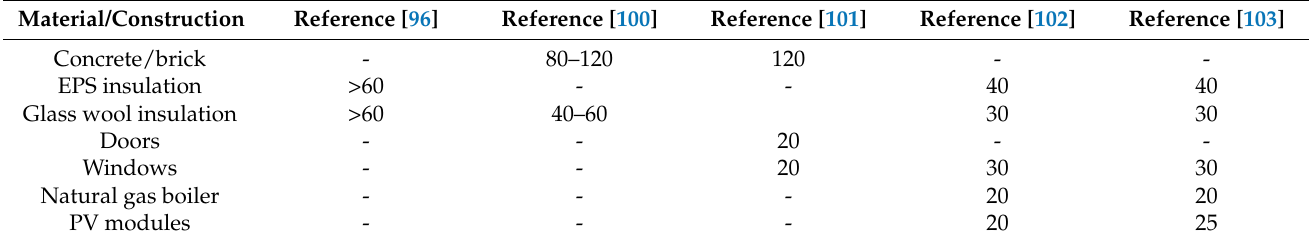
Table 9. The lifespan of typical construction materials and buildings